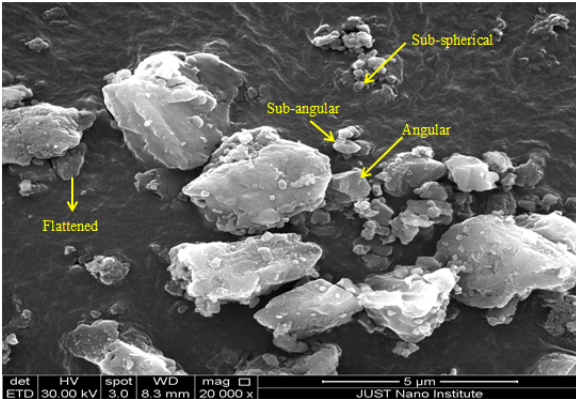
Figure 2: SEM micrograph of irregular shapes and sizes of car- bonized Es.